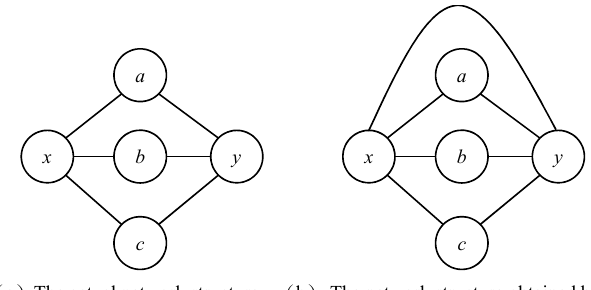
Figure 3. Example of the causes of redundant edges.